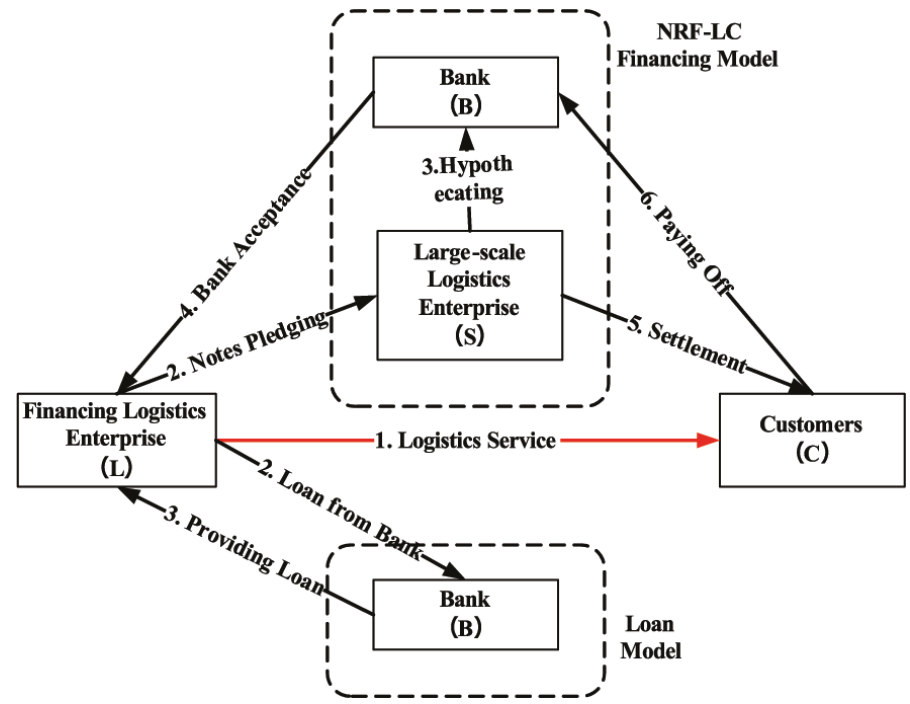
Figure 5: The logistics enterprise financing